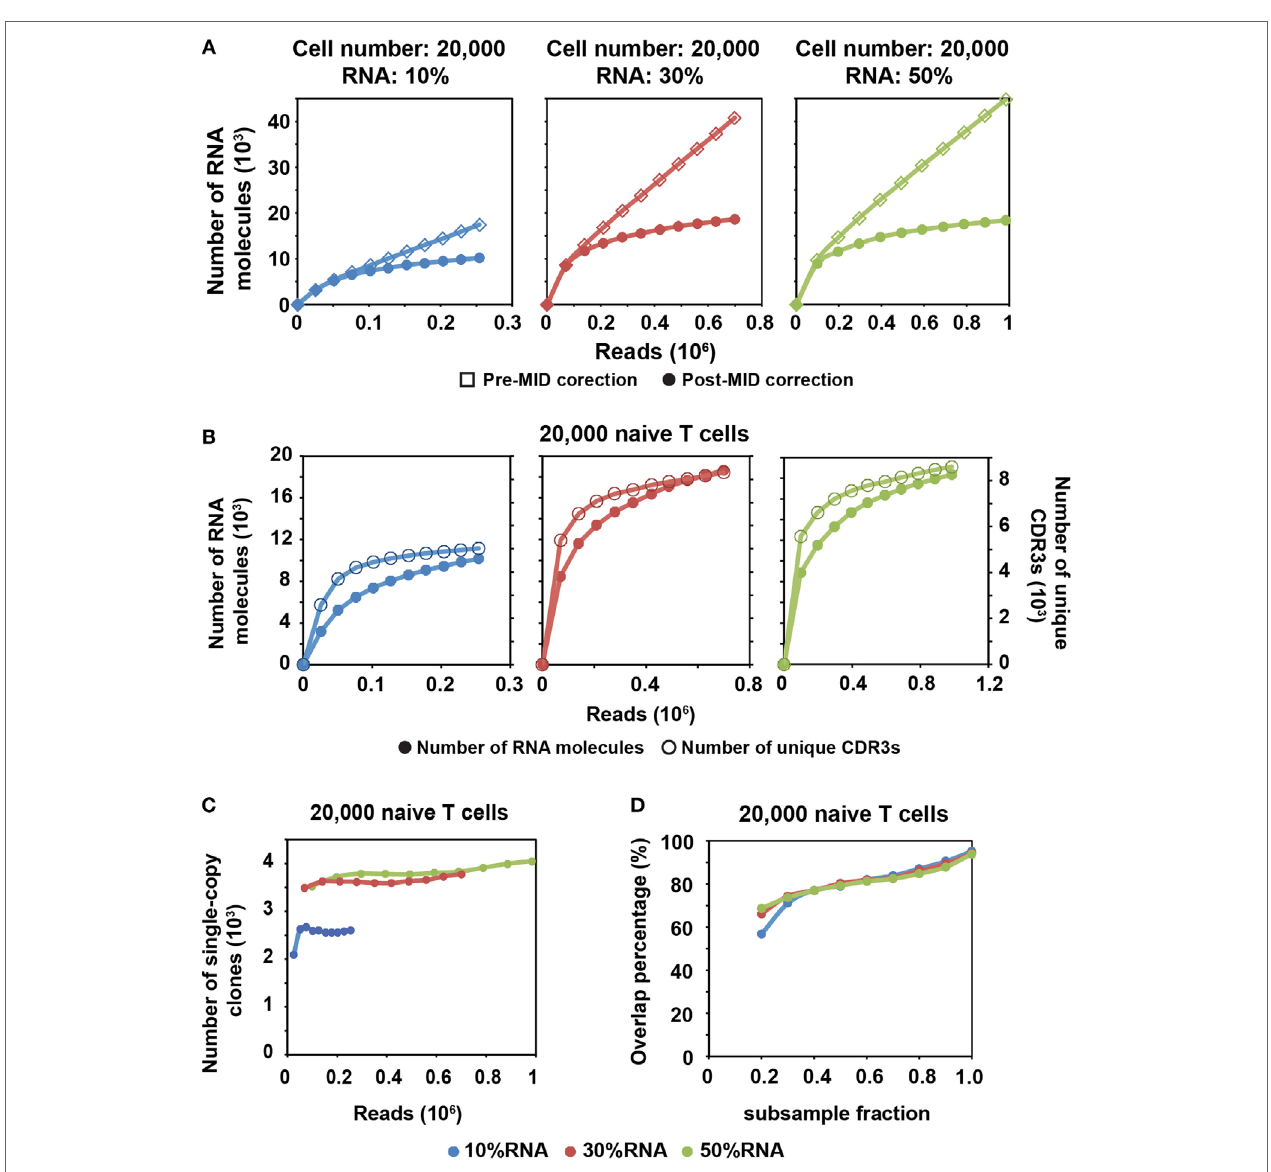
FIGURe 2 | MID Clustering-based IR-Seq is capable of accurate digital counting of T cell receptor (TCR) RNA molecules. (A) Rarefaction curve of detected TCR RNA molecules before and after error correction on molecular identifiers (MIDs) in 20,000 naïve CD8 + T cells for three RNA input amounts. Data from other cell inputs are in Figure S4 in Supplementary Material. (B) Comparison of rarefaction curve of detected RNA molecules and unique complementarity-determining regions 3 (CDR3s) in 20,000 naïve CD8 + T cells for three RNA input amounts. (C) Rarefaction curve of number of unique CDR3s with single RNA copy in 20,000 naïve CD8 + T cells for three RNA input amounts. Sequencing reads were subsampled to different depth and unique CDR3s were tallied. Data from other cell inputs are in Figure S6A in Supplementary Material. (d) The percentage of overlapping clones with single RNA copy at different sequencing depths by sub-sampling in 20,000 naïve CD8 + T cells for three RNA input amounts. The overlapping clones were compared between two adjacent sub-samplings and overlap percentage was calculated by dividing the number of overlapping clones by the total number of clones observed in the deeper sub-sampling. Data from other cell input are in Figure S6B in Supplementary